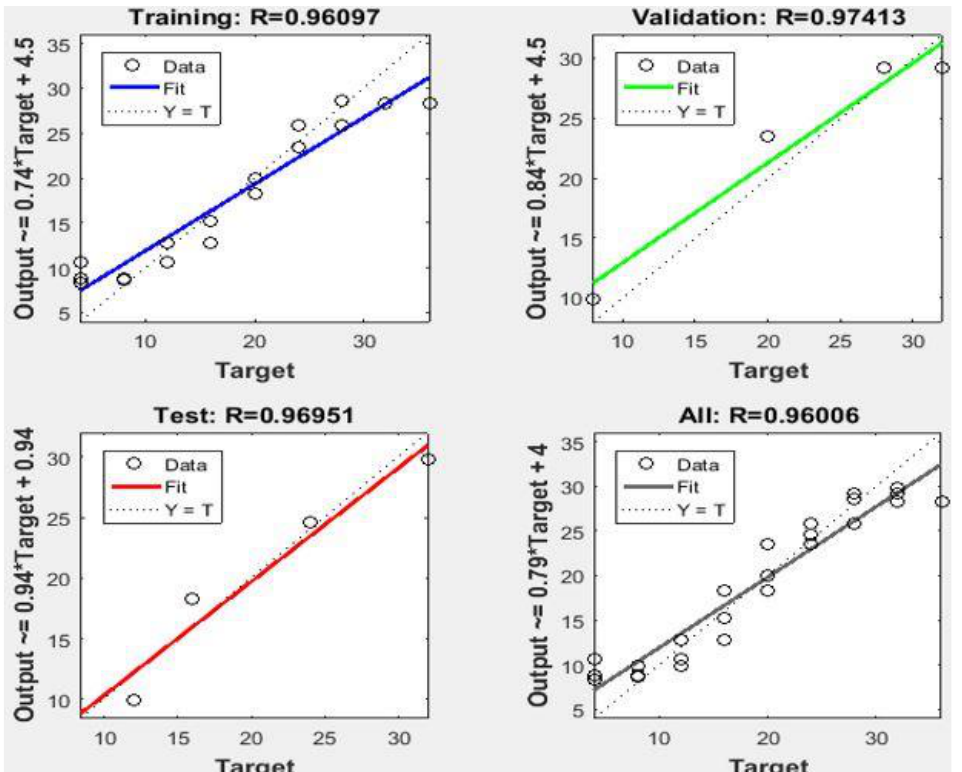
Figure 8. Dispersion of data relative to the regression line .